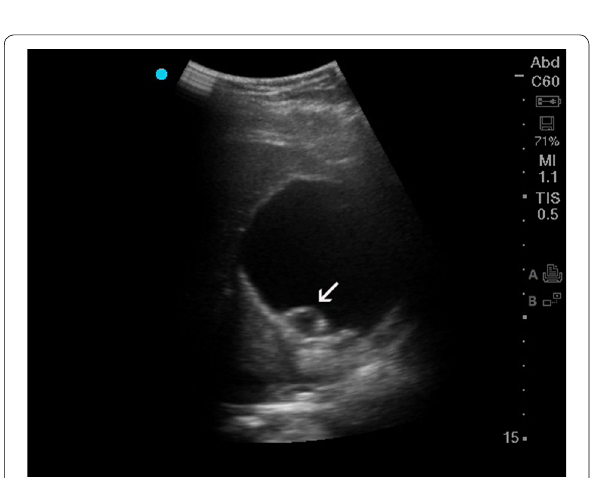
Fig. 2 Ultrasound image of an Echinococcus cyst. Note the separation of the wall from the cyst (arrow) can be visualized. According to the WHO classification system, this cyst would be considered a type CE2 active cyst